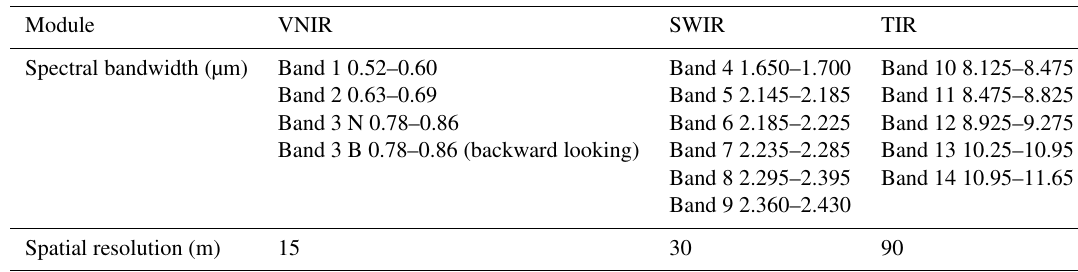
Table 1. Wavelength ranges and spatial resolutions of ASTER bands (Abrams,